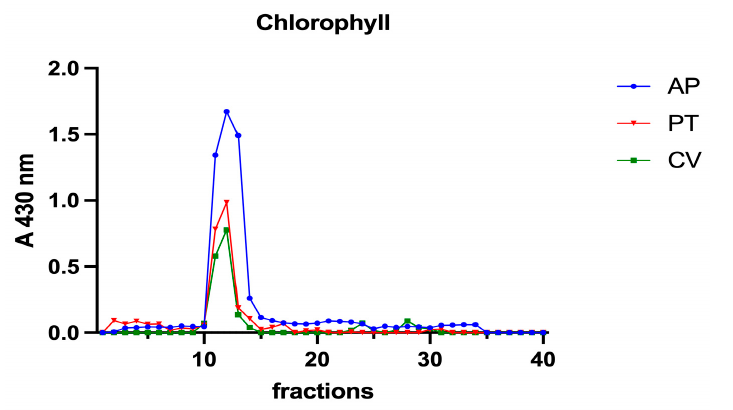
Figure 5. A chromatographic profile of phycocyanin after SEC of the A. platensis extract. Phycocya- nin concentration is reported as mg mL − 1 . The chromatographic profile is the mean of two chromatographies.